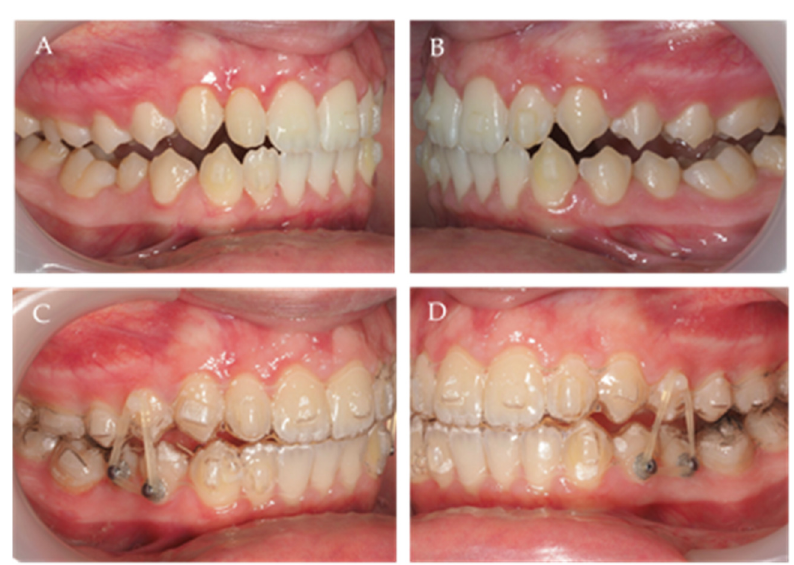
Figure 11. ( A , B ) Photographs after second AA and with aligner 1 ( C , D ) from third AA stage with vertical elastics.